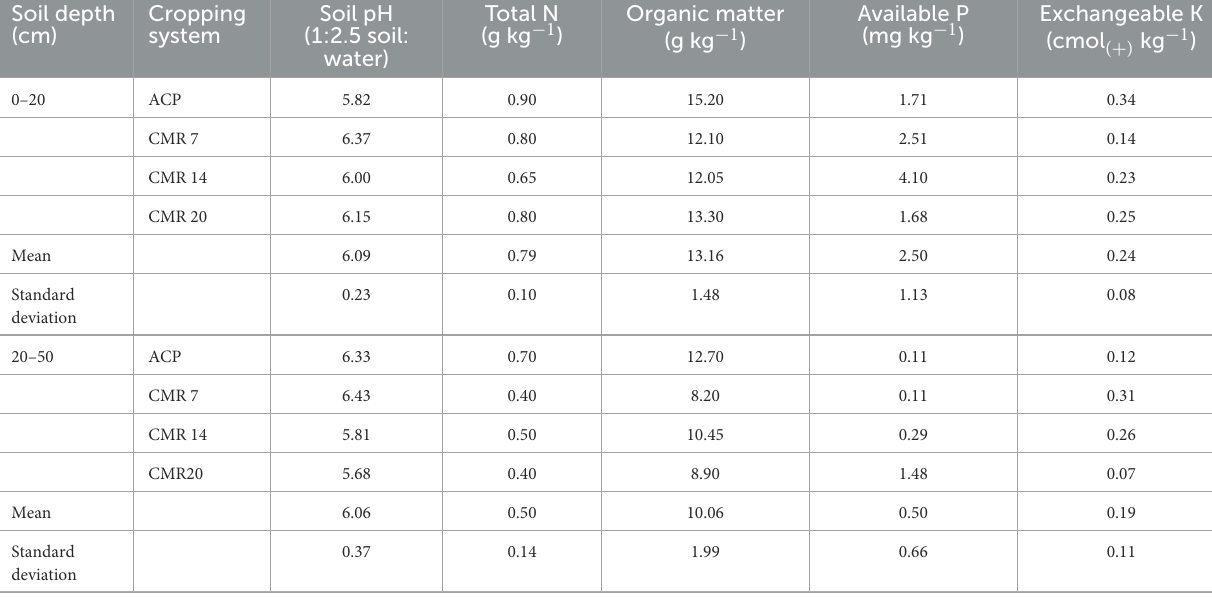
TABLE 3 Soil nutrient dynamics within 0–20cm and 20–50cm soil depths under various cropping systems.